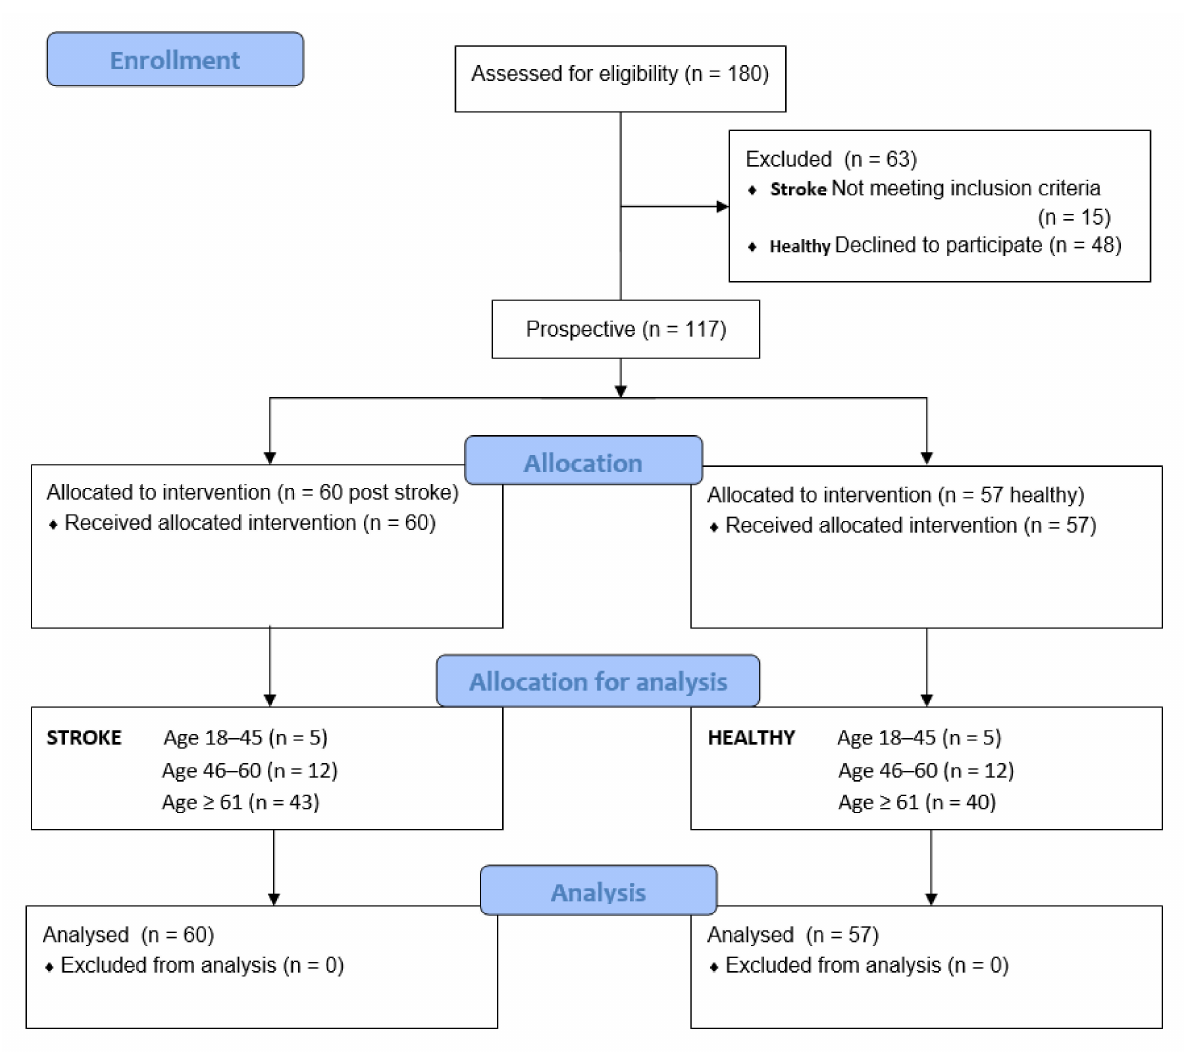
Figure 1. Flow of participants through each stage of the study. Table 1. Biometric data of the post-stroke patients and healthy control